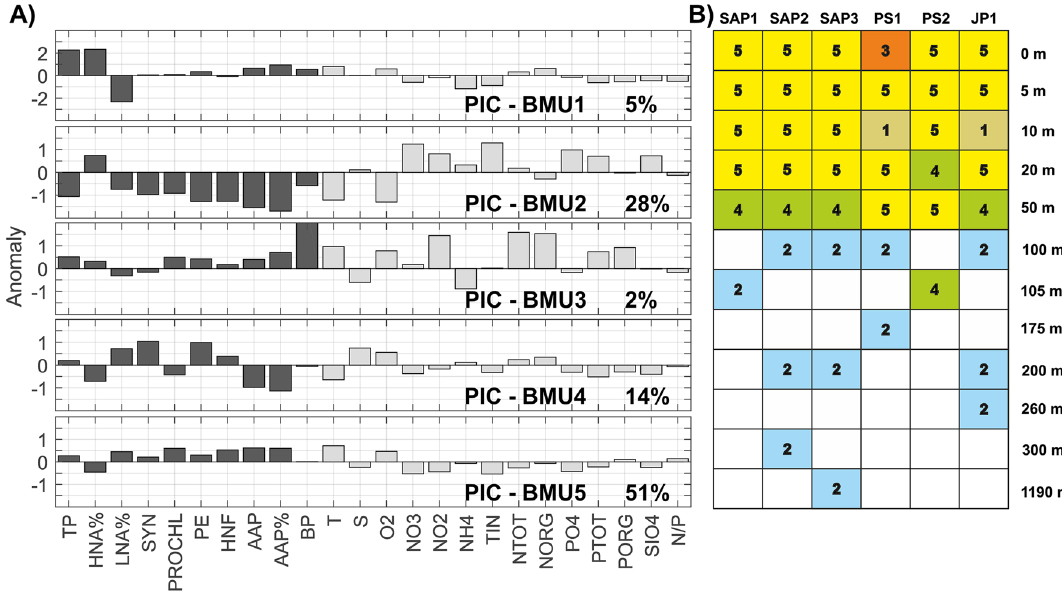
Figure 2. ( A ) Bar plot representation of biotic (black) and abiotic (grey) parameters for neural gas best- matching units (picoplankton-PIC-BMUs) with relative frequency appearance for each neuron. TP-total prokaryotes, SYN- Synechococcus , PROCHL- Prochlorococcus , PE-picoeukaryotes, HNF-heterotrophic nanoflagellates, AAP-aerobic anoxygenic phototrophs, AAP%-portion of AAP, HNA% percentage of high nucleic acid content bacteria, LNA%-percentage of low nucleic acid content bacteria-LNA%, BP-bacterial production. ( B ) Water column distribution of Neural gas best-matching units (BMU, labels with numbers, and stained with a different colour for clearance, coloured non-labelled squares shows clarity) for measuring stations (SAP1-3, PS1-2 and JP1). The software MATLAB. version 7.10.0 (R2018). Natick, Massachusetts: The MathWorks Inc. (2018) (https:// www. mathw orks. com/) was used to generate the